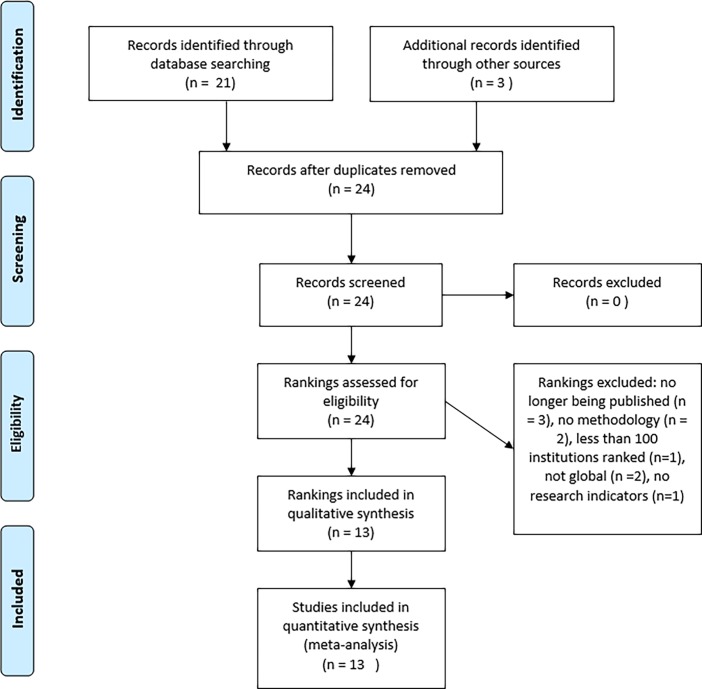
PRISMA flow diagram.